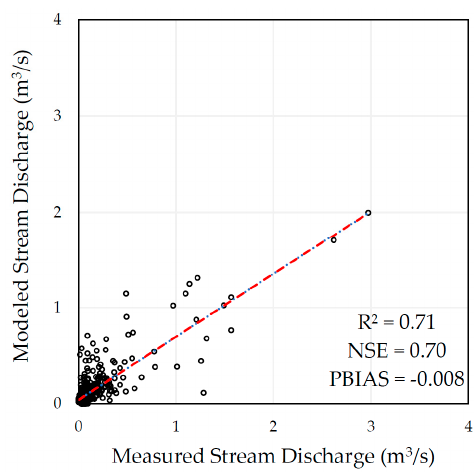
Figure 3. Streamflow scatterplot of modeled and observed average daily streamflow from USGS gauge 0111528 during 2009–2010.